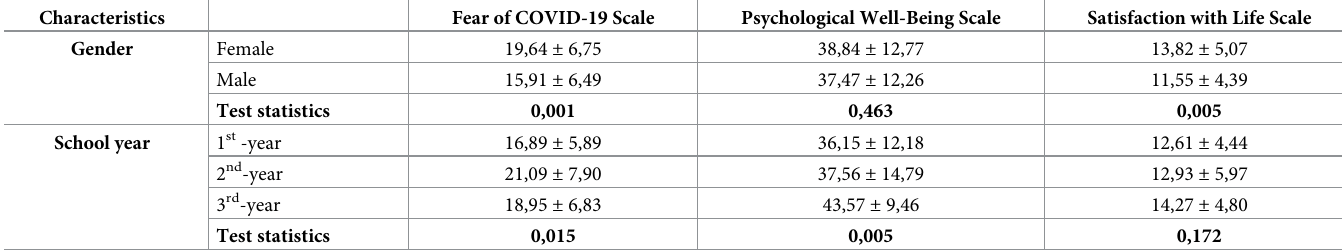
The variables that were found to be significant in the model with the backward regression modeling were satisfaction with life scale, gender, and school year. A one-unit increase in the satisfaction with life scale increased the fear of COVID-19 scale score by 0.224 units, and this increase was statistically significant (p = 0.030). The female gender increased the Fear of COVID-19 Scale score by 2.845 units compared to the male gender, and this increase was sta- tistically significant (p = 0.011), too. In other words, it can be said that females experienced higher fear of COVID-19 than males. Being a 2nd-year student also showed a significant increase compared to being a 1st and 3rd-year student (p = 0.007). Being a 2nd-year student increased the Fear of COVID-19 Scale score by 3.165 units. Other variables did not have a sig- nificant effect on the dependent variable (Table 6). Table 3. Comparison of the students’ mean scores on the fear of COVID-19, psychological well-being and satisfaction with life scales according to some socio- demographic characteristics.